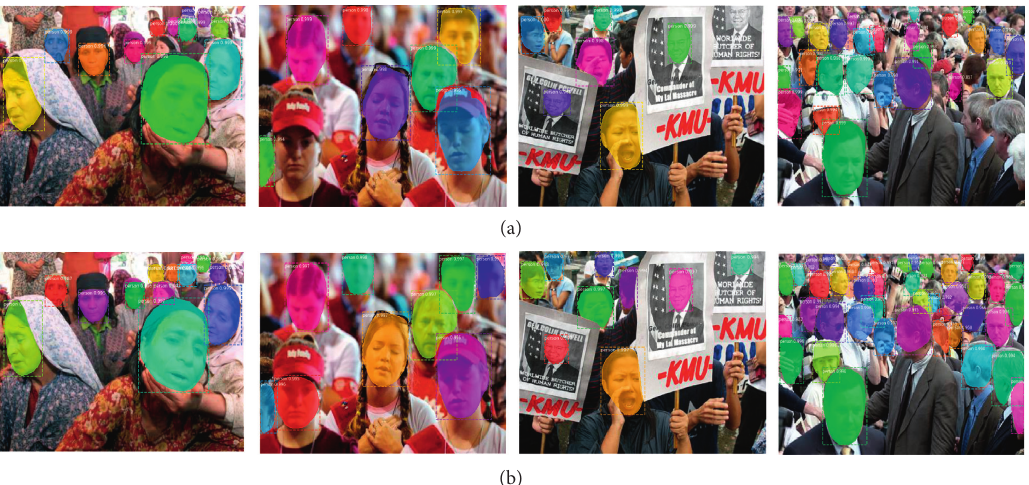
Figure 6: Different detection results of Mask R-CNN and G-Mask in the complex scene of FDDB dataset. (a) Mask R-CNN model and (b) G-Mask